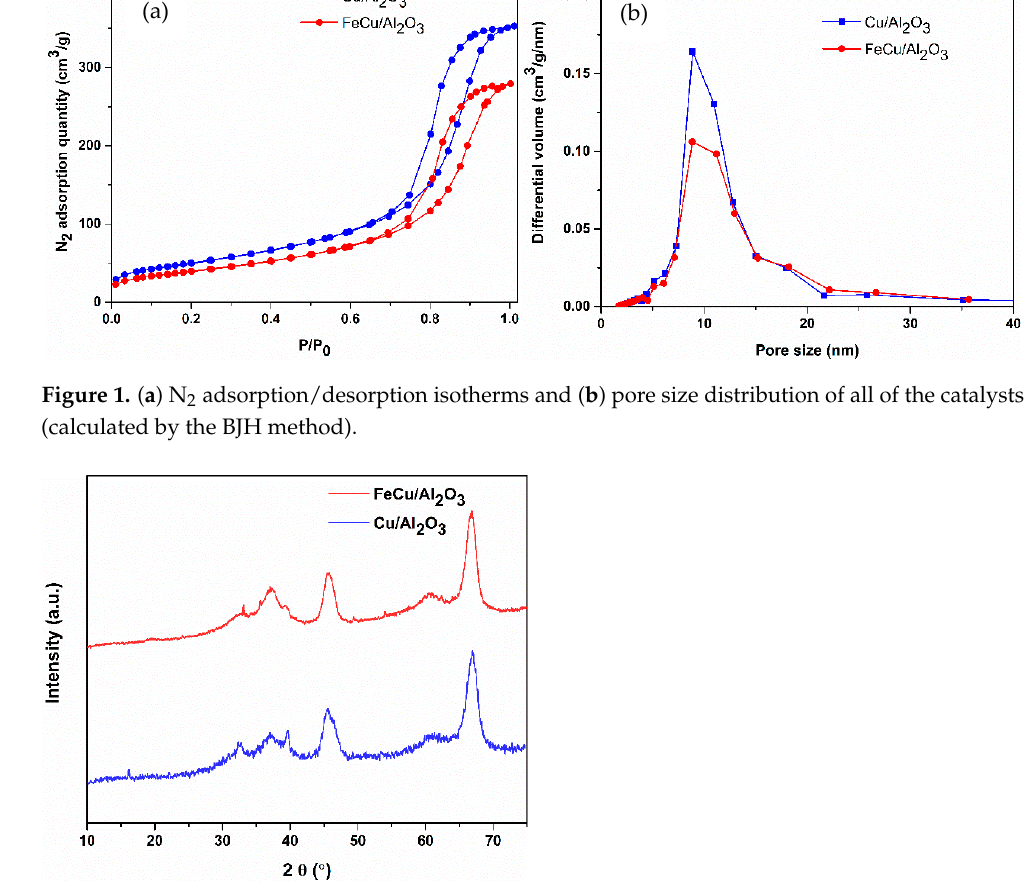
2 O 3 -supported